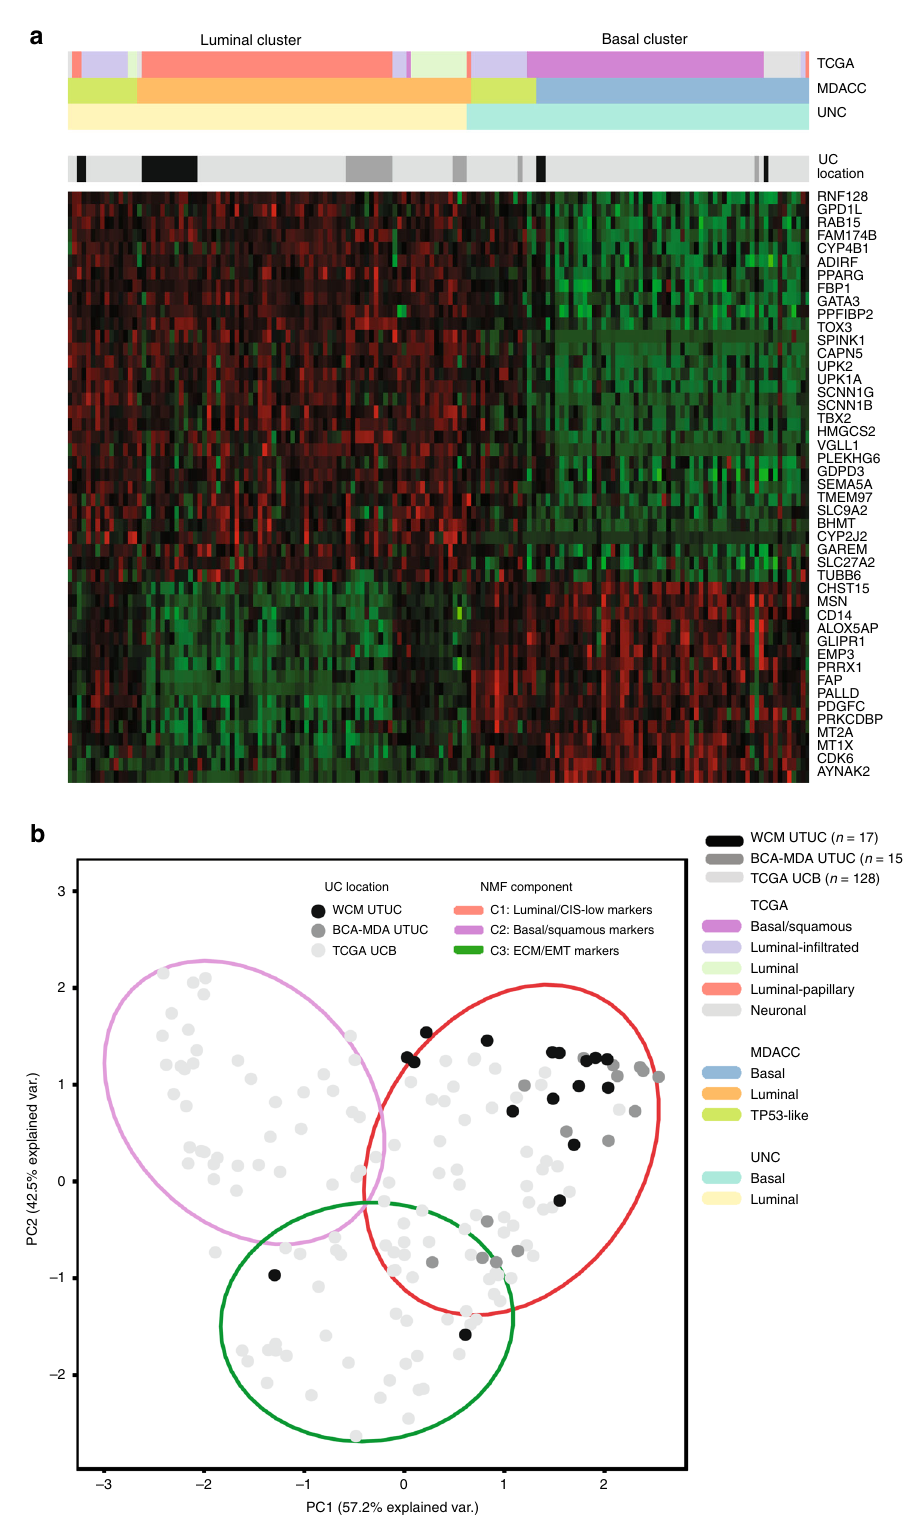
Fig. 3 UTUC is predominantly luminal. a Supervised consensus clustering and heatmap of mRNA expression data from WCM UTUC, BCM-MDA UTUC, and TCGA UCB metadataset. BASE47 classi fi er (UNC) genes are listed on the right. Assigned TCGA, MDACC, and UNC clusters are represented on top (color key, bottom right). WCM UTUC and BCM-MDA UTUC cluster with the luminal subtype (yellow vertical bars) by UNC criteria, luminal subtype by MDACC criteria (orange horizontal bars) and luminal-papillary subtype by TCGA classi fi cation (red horizontal bars). b Non-negative matrix factorization (NMF) of WCM UTUC, BCM-MDA UTUC, and TCGA UCB tumors segregates gene expression along three principal components: basal/squamous (purple), luminal/CIS-low (pink), and extracellular matrix/epithelial – mesenchymal transition (ECM/EMT) (green). WCM UTUC tumors represented as black dots and BCM-MDA tumors represented as dark gray dots cluster with the luminal/CIS-low